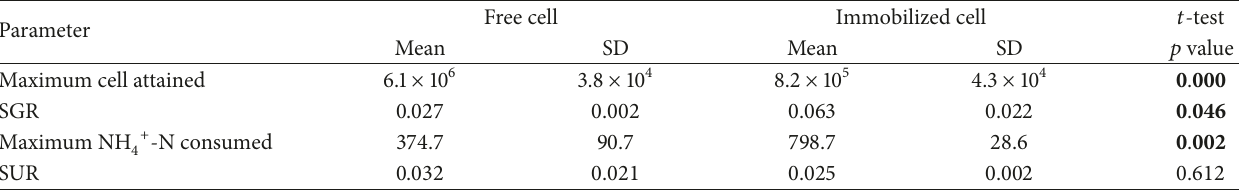
Significant value of 𝑝 value ≤ 0.05 is indicated in bold. Table 2: The stability of microalgae immobilized bead and percentage of cell leakage. Initial bead size